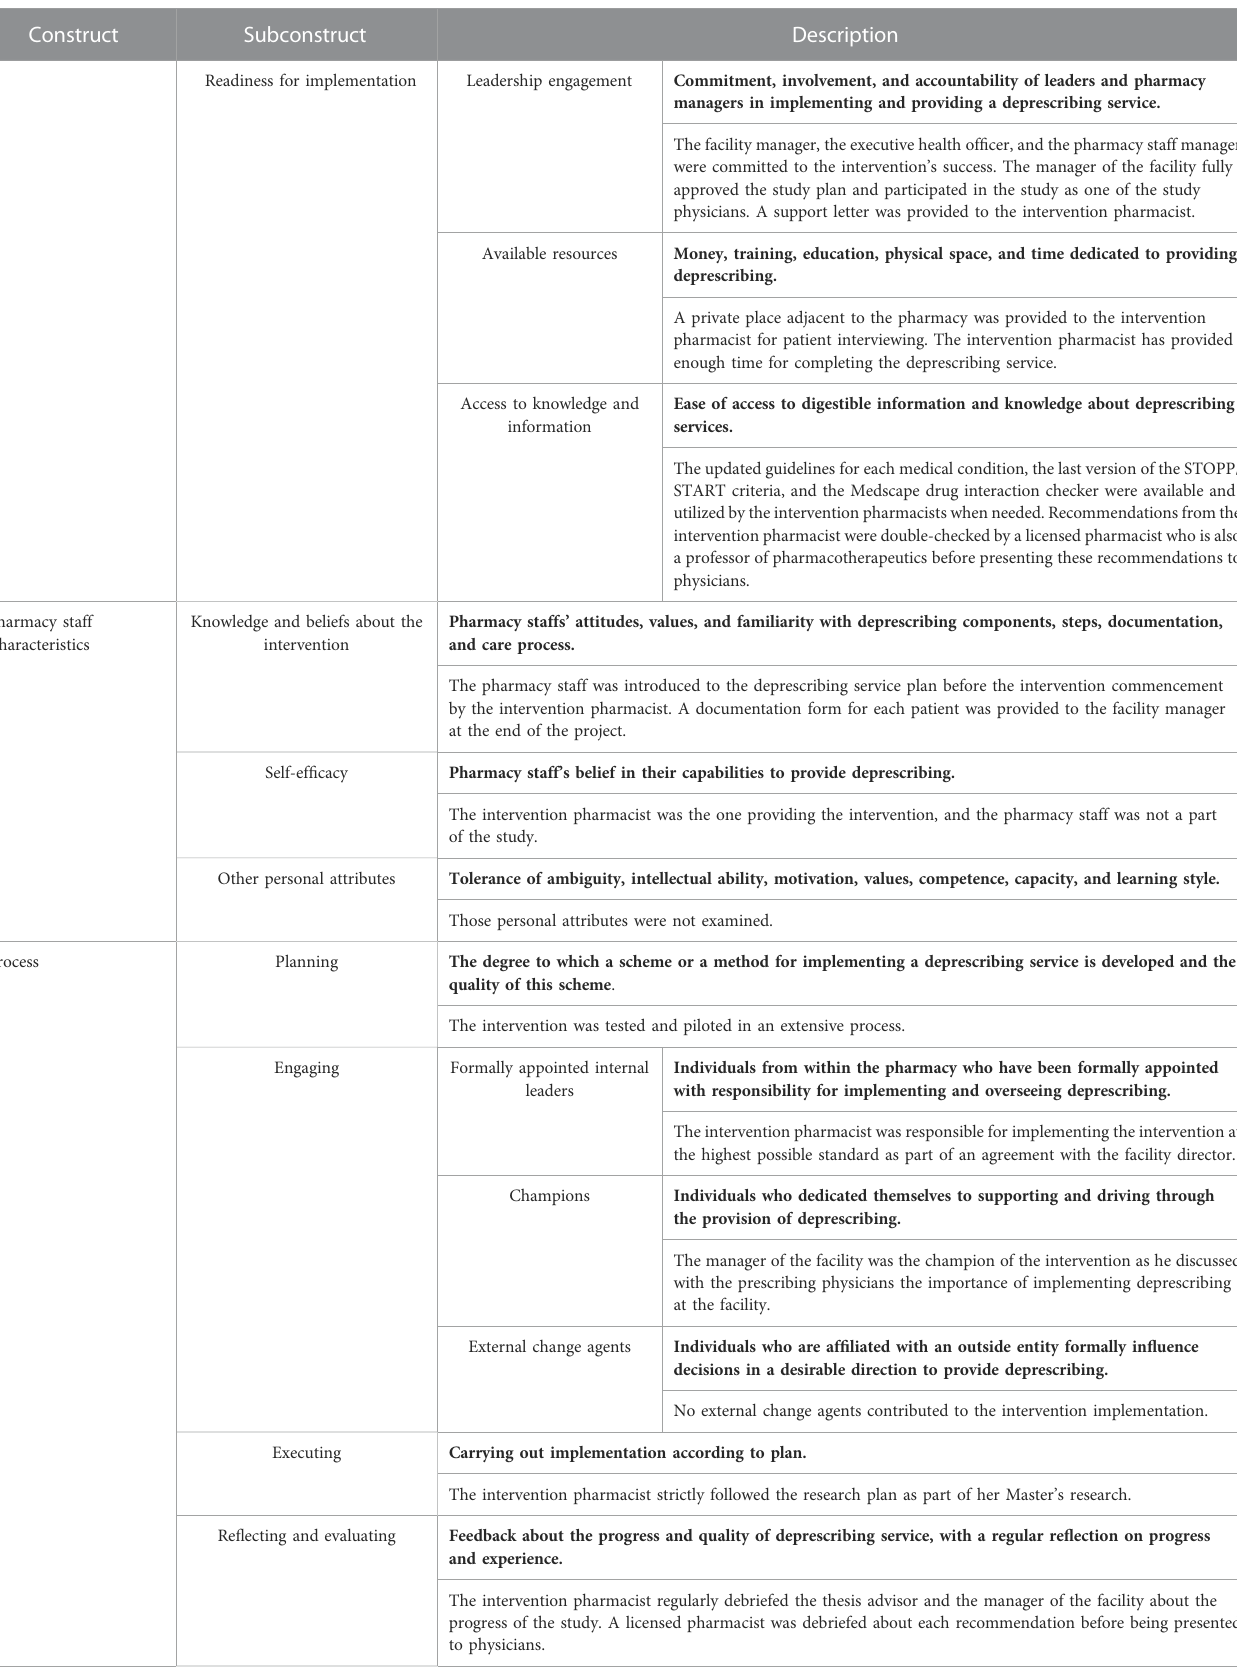
TABLE 1 ( Continued ) The deprescribing intervention setup mapped to the adapted Consolidated Framework for Implementation